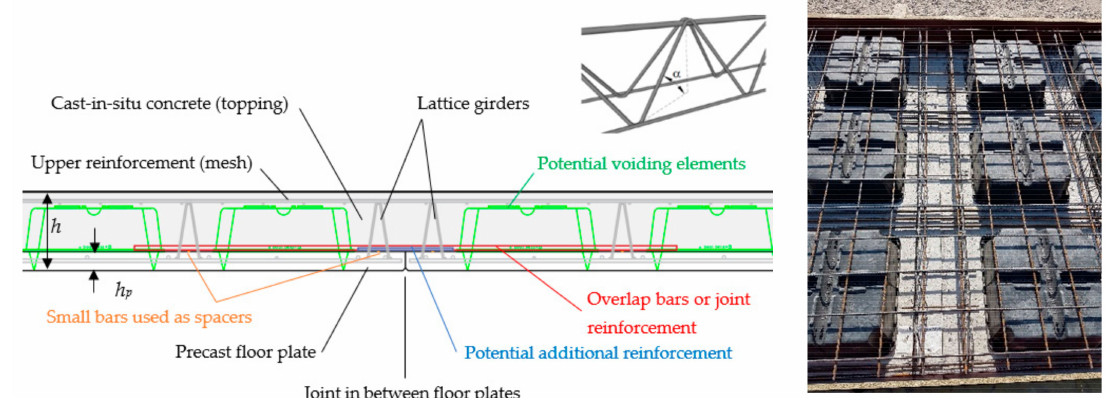
Figure 1. Longitudinal joint detail with an indication of typical (potential) components and details of the lattice